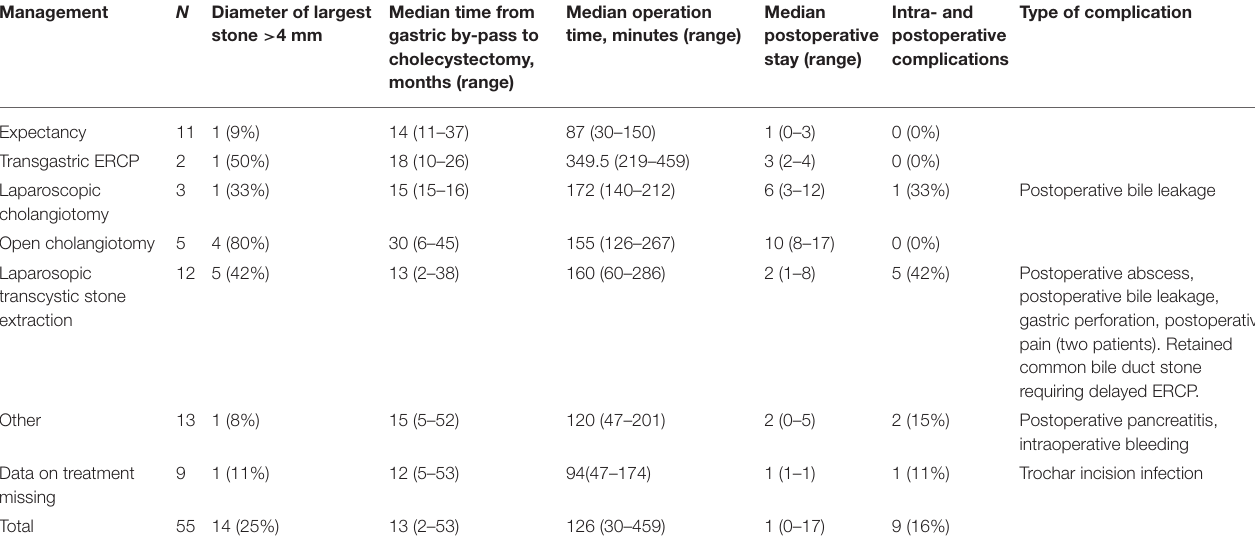
TABLE 1 | Treatment